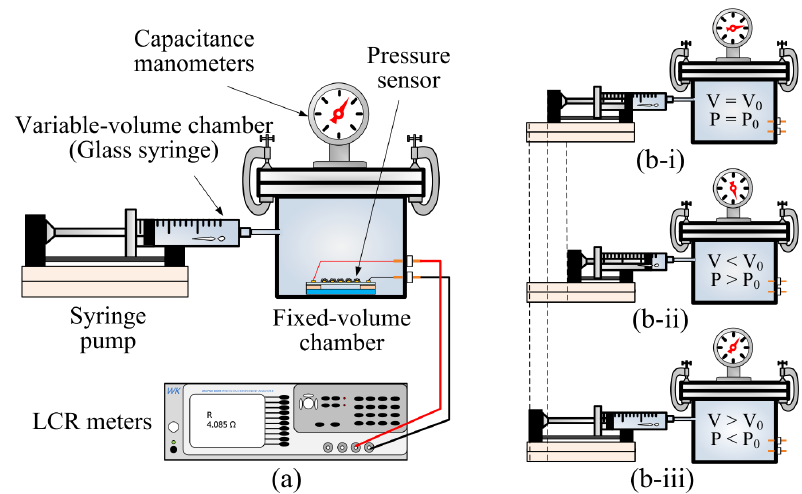
Figure 7. ( a ) Schematic diagram of experimental setup for pressure measurement. ( b ) The schematic of the internal pressure changes of the chamber system when the volume of the variable-volume chamber (syringe pump) ( b-i ) does not change, ( b-ii ) decreases, and ( b-iii ) increases.